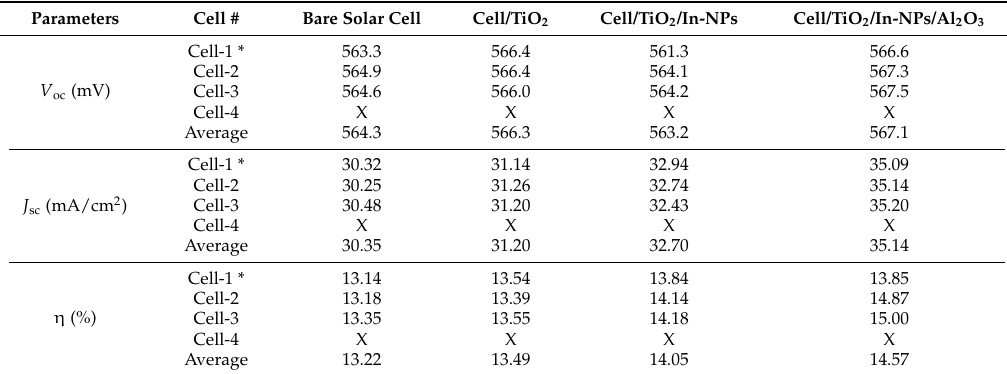
Table 2. Photovoltaic performance of three bare cells, cells with a TiO 2 spacer layer, cells with In-NPs, and cells with In-NPs embedded in Al 2 O 3 .